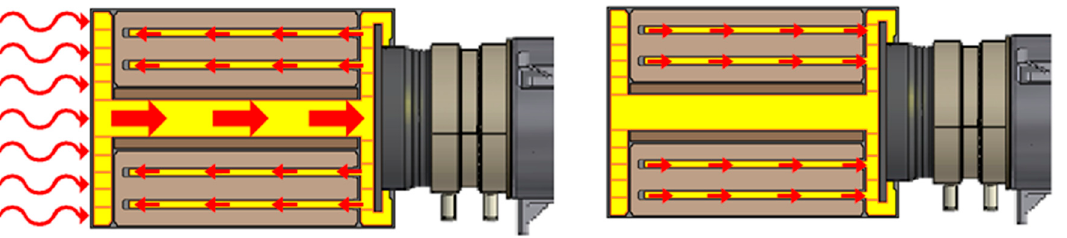
Figure 3. TES module schematic for charging ( left ) and discharging ( right ) mode.